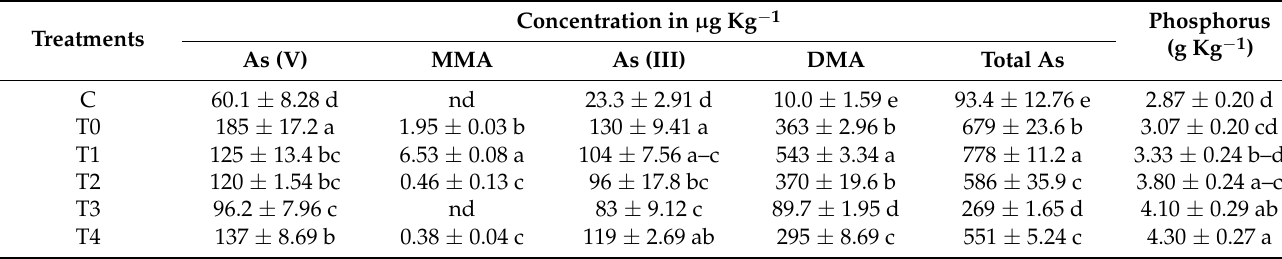
Table 2. The contents of arsenic (As) species and orthphosphate (P) in rice ( Oryza sativa L.) grain after exposure of As and combined As and P treatments. Treatments, C and T0, indicate untreated control, and 10 mg kg − 1 As treated group, respectively. The base soil As content in control group was 35 µ g kg − 1 . T1, T2, T3, and T4 denote combined treatments, 40 mg kg − 1 P, respectively. Results were expressed as a mean ± standard error (SE) of three biological and two technical replicates per sample. Significant differences ( p < 0.05) among different treatments are shown by different letters. As (III), arsenite; As (V), arsenate; MMA, monomethyl arsonic acid; DMA, dimethyl arsenic acid. Concentration in µ g Kg − Treatments